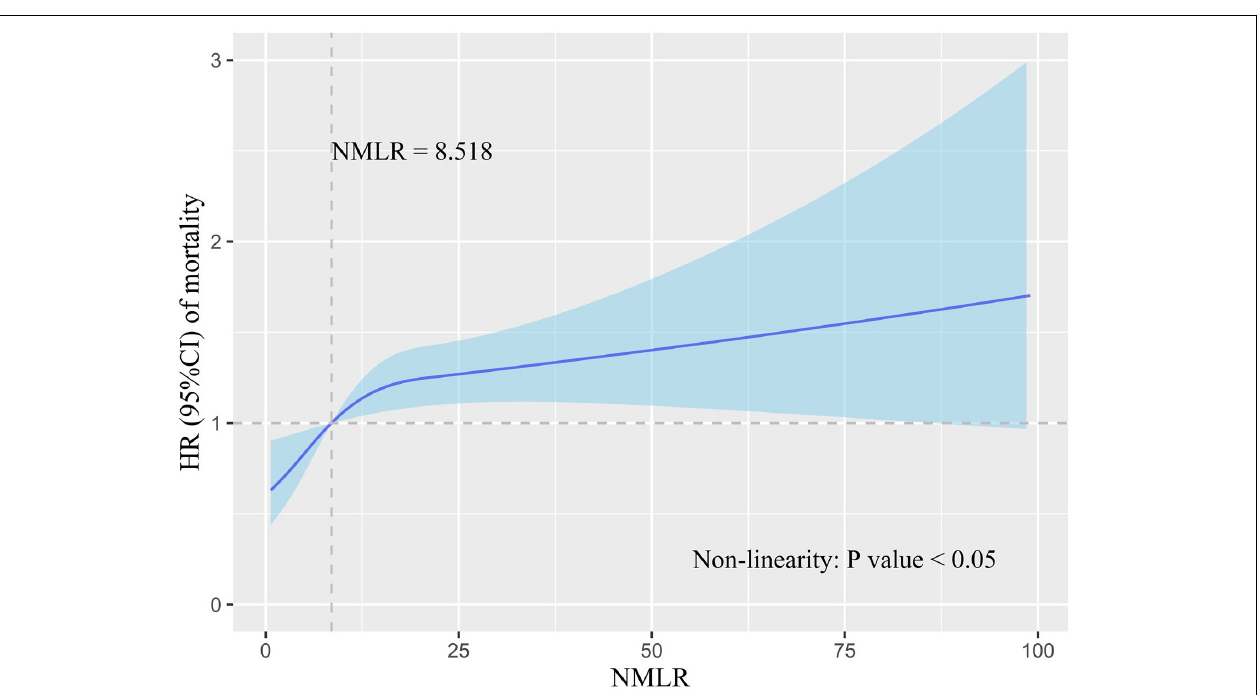
FIGURE 3 | Association of admission NMLR with in-hospital mortality risk. HR is indicated by the solid blue line, and 95% CI is denoted by the shaded blue area. The model was adjusted for cofounders with a P -value < 0.05 in multivariate Cox analysis. The reference point (HR = 1) was the point where the admission NMLR value was 8.518. The P -value for non-linearity was less than 0.05. HR increased with the increase in admission NMLR. However, the growth rate of HR slowed down after the admission NMLR exceeded 8.518. NMLR, (neutrophil+monocyte)/lymphocyte ratio; HR, hazard ratio; CI, confidence